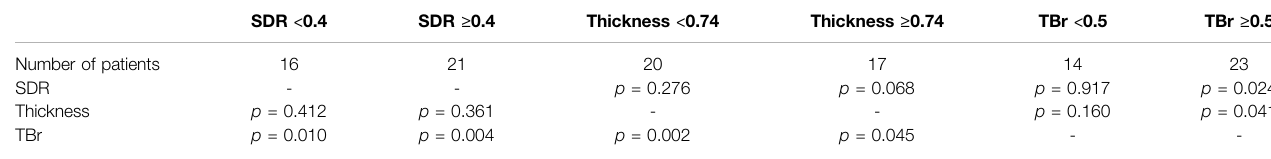
TABLE 3 | Correlation of D/E with each factor in groups with SDR above 0.5 and below, thickness above 0.74 and below, and TBr above 0.5 and below. SDR < 0.4 SDR ≥ 0.4 Thickness < 0.74 Thickness ≥ 0.74 TBr < 0.5 TBr ≥